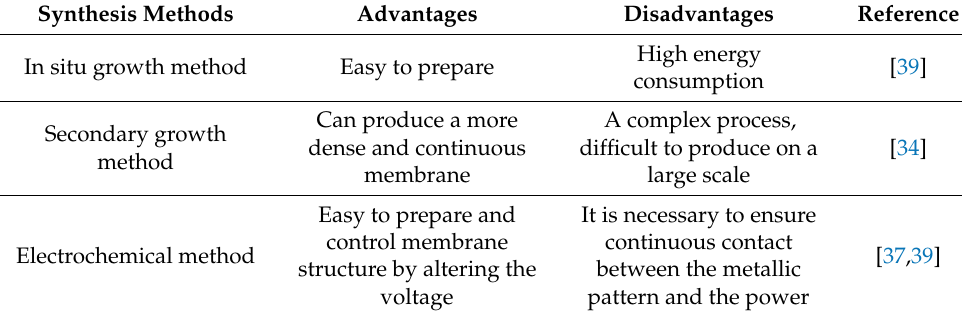
Table 1. Characteristics of the synthesis